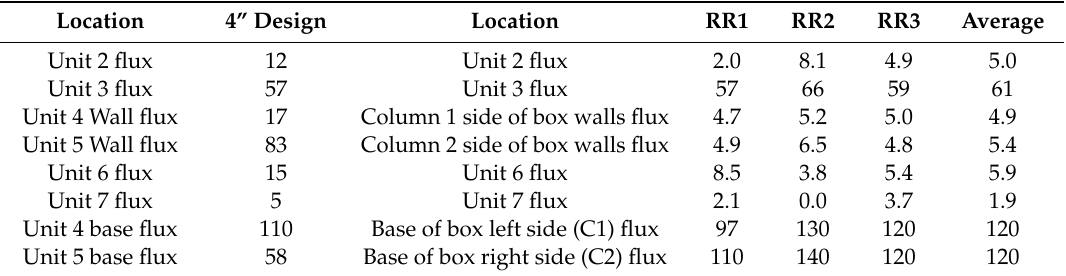
Table 9. Wall deposition fluxes (g / m 2 / h) for a 30 wt% solids concentration feed at an inlet air temperature of 170 ◦ C (RR1 = run 1, RR2 = run 2, RR3 = run 3). The standard errors were 13 g / m 2 / h for Unit 3 and the base of the box and 2 g / m 2 / h for all other fluxes.